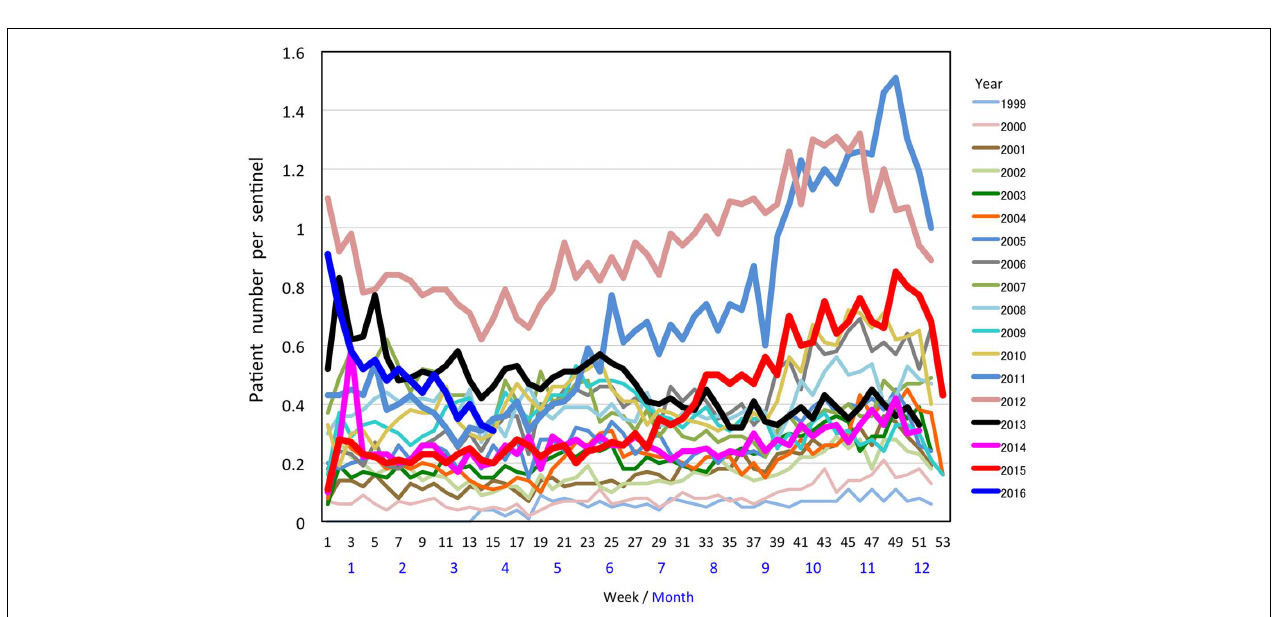
FIGURE 2 | Weekly cases of M. pneumoniae pneumonia in Japan between 1999 and 2015 reported by the NESID. http://www.nih.go.jp/niid/ja/10/2096- weeklygraph/1659-18myco.html.